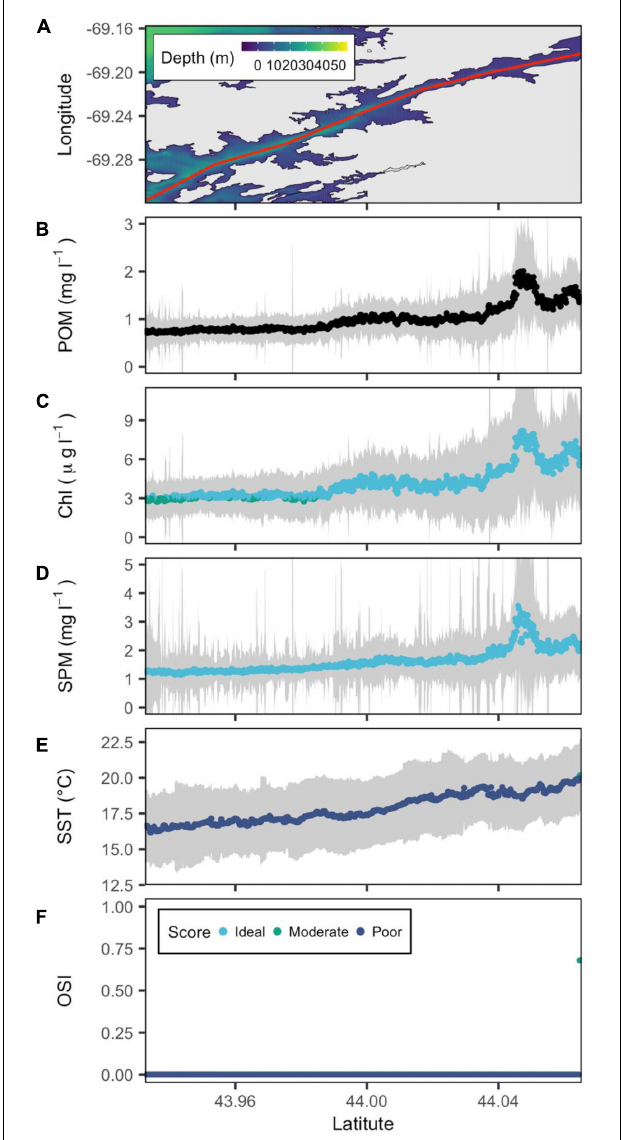
FIGURE 7 | Bathymetric map of the St. George River estuary (from downstream to upstream left to right) with a red line showing the central transect. (A) POM (B) , SPM (C) , Chl a (D) , and SST (E) are reconstructed from remote sensing data, and OSI (F) is derived following the method of Snyder et al. (2017). Gray color belts show standard deviation of POM, SPM, Chl a, and SST derived in summer (June–September) over the period 2016–2020, with their median values depicted by blue, green, and cyan points that denote poor, moderate and ideal conditions for oyster aquaculture,